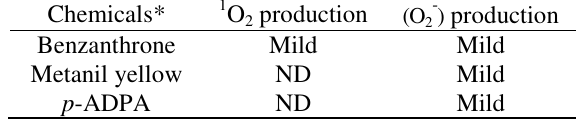
Figure 2. Relationship between the production of 0 -2 and concentration (0-20 µ g/mL) of the following: 1, metanil yellow; 2, p -ADPA: and 3, benzathrone. Table 1. A comparison of chemical agents tested for 1 o